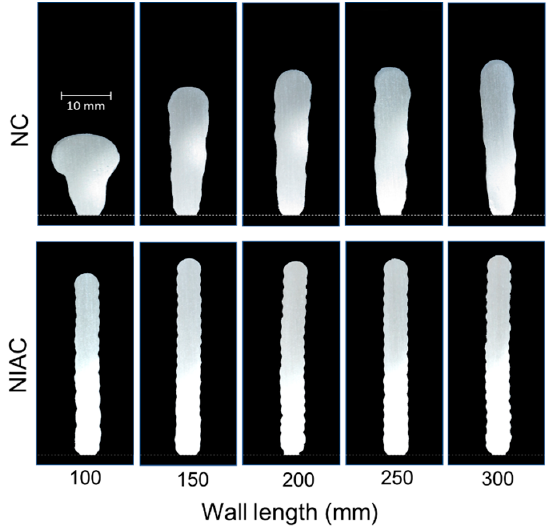
Figure 11. Comparison between 200 mm-long walls deposited with the NIAC and the NC approaches under equivalent interpass temperatures.